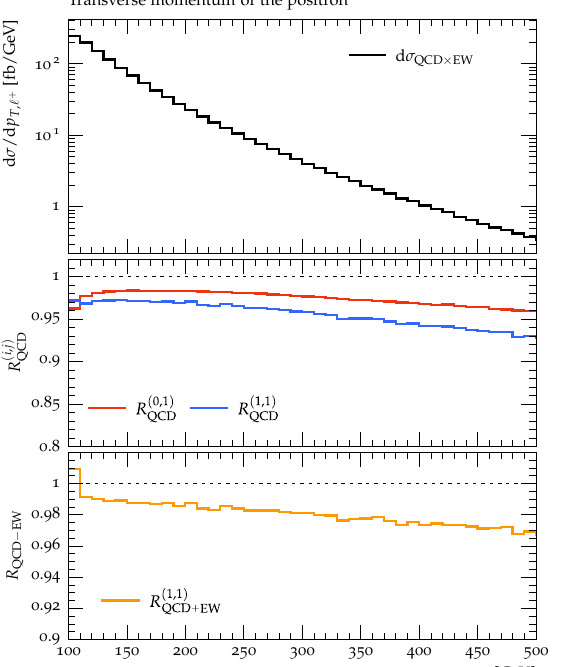
Figure 3 . Transverse momentum distribution of the positively charged lepton. See the caption in figure 2 and the text for details.